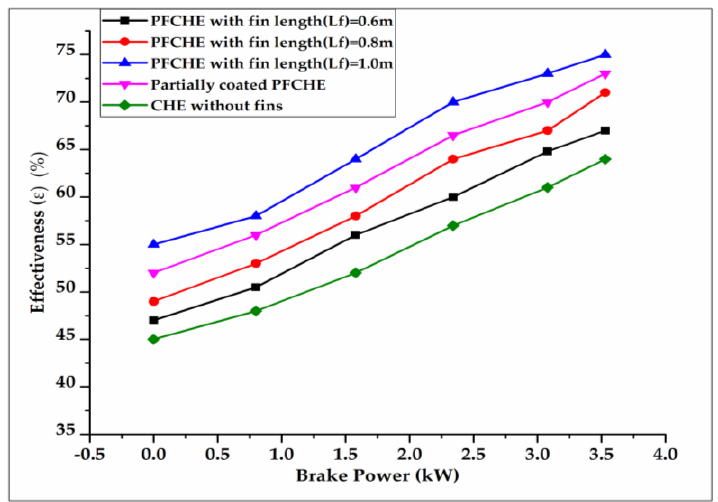
Figure 7. Effectiveness of heat exchanger with fin geometry.